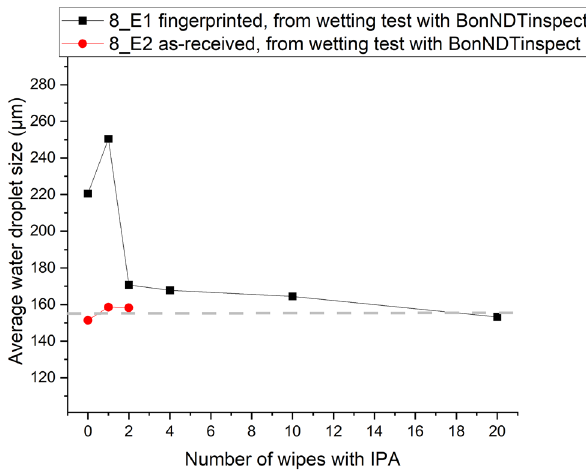
Fig. 11 Effect of performing several subsequent isopropanol (IPA) wipe-off cleaning steps on the average water droplet size observed during AWT inspection of fingerprinted R-ABS substrates